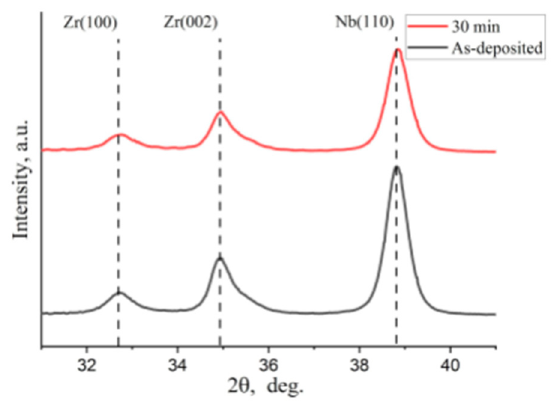
Figure 6. Diffraction patterns for as-deposited and irradiated Zr/Nb NMC.